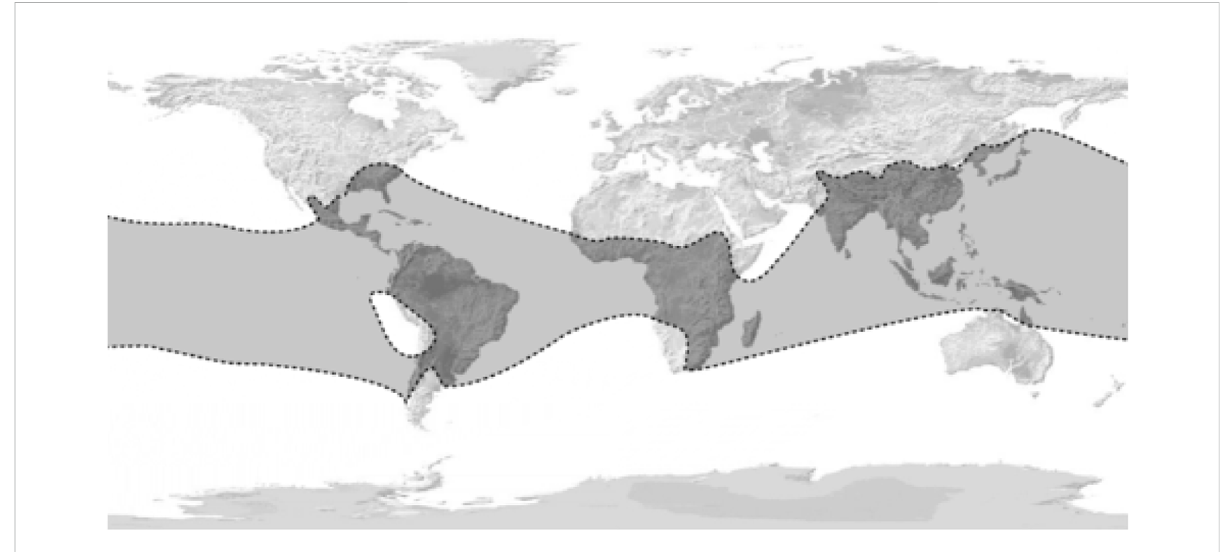
FIGURE 1 Global Natural Bamboo Habitat (National Geographic, 1980).